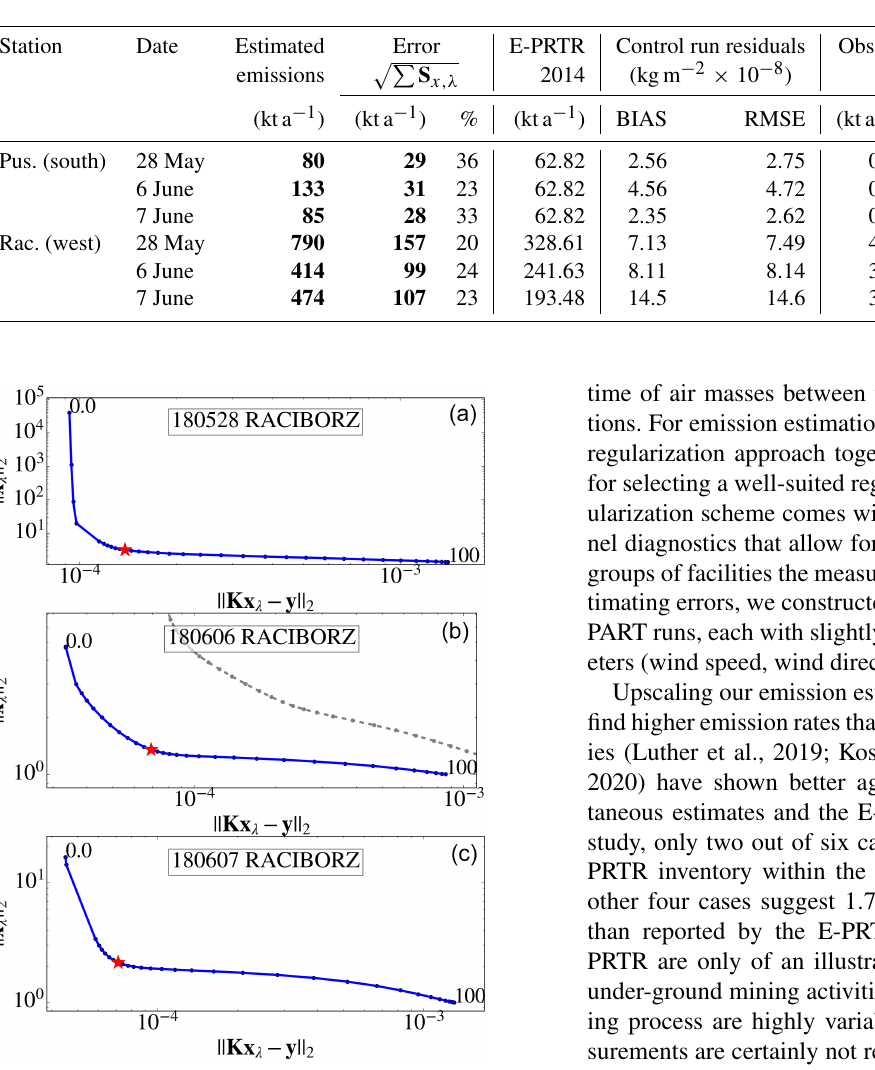
Figure 12. The L-curves for the three Raciborz (W) case studies. Panel (b) additionally depicts the L-curve of the same case study (dashed grey line) but under consideration of the full data set in- cluding the morning and afternoon hours, which suffered from for- ward model errors and are omitted in the final analysis (blue curve). The regularization parameters, λ , range from 0 to 100. The red star marker depicts the respective λ used for the emission